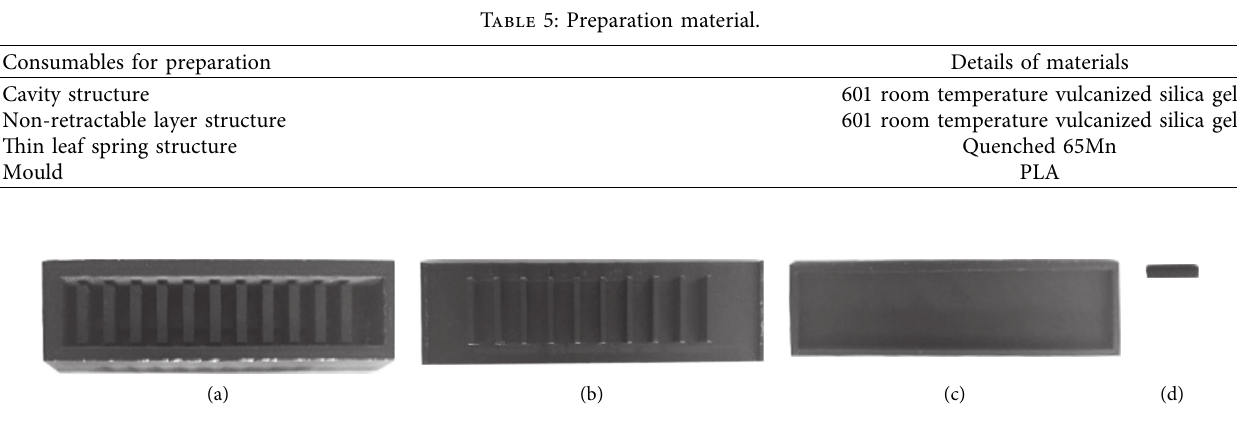
Figure 3: Mould structure. (a) Cavity mould main body. (b) Cavity mould upper cover. (c) Nonretractable layer mould. (d) Gas inlet forming plug.